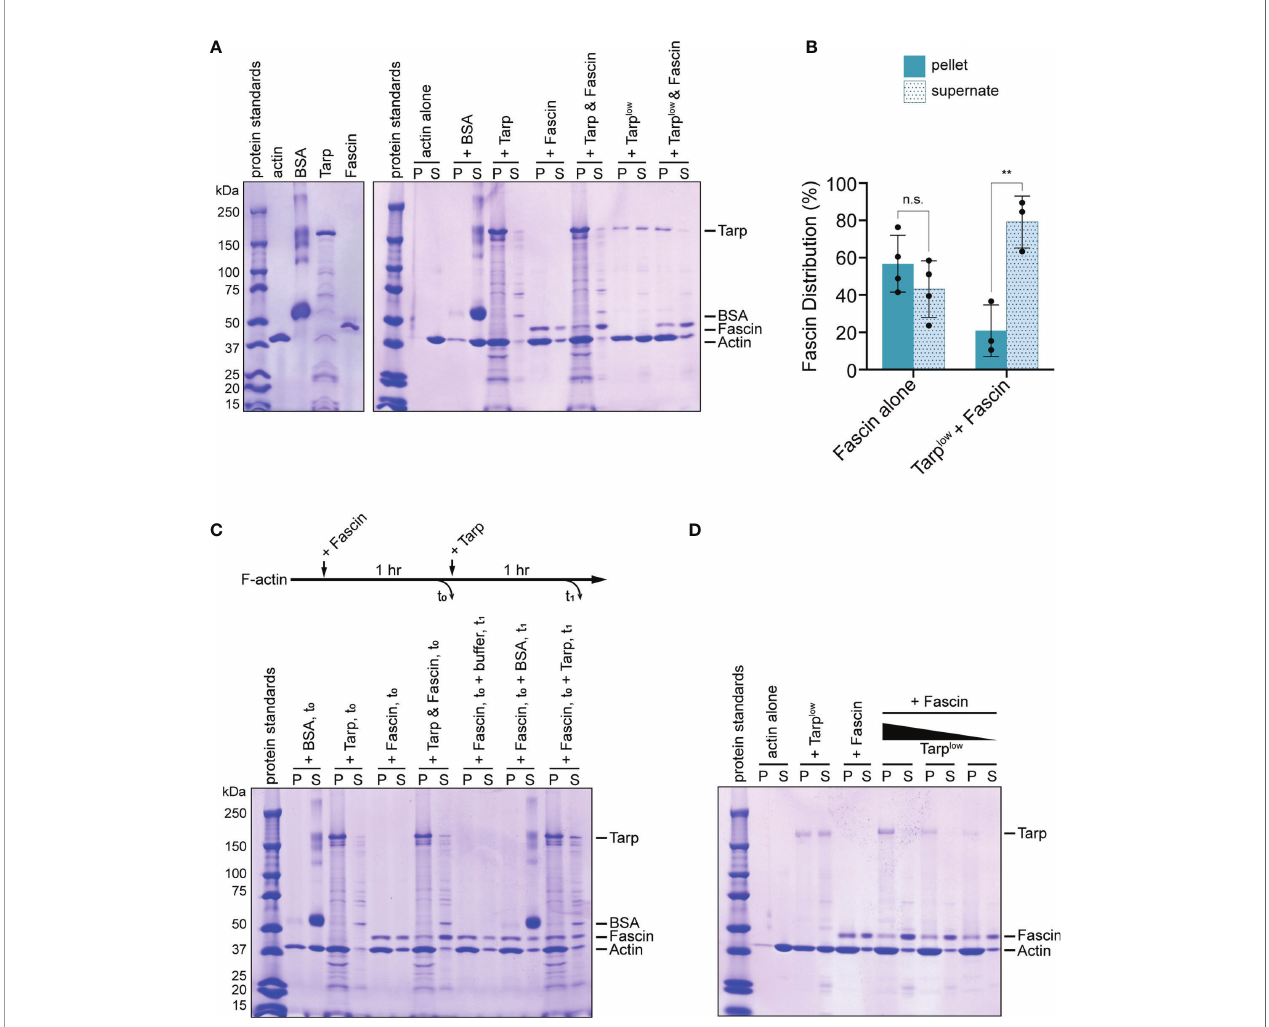
FIGURE 6 | Tarp outcompetes Fascin in F-actin bundling formation in vitro . (A) An in vitro F-actin bundling assay was performed using puri fi ed Tarp and Fascin, alone or in combination. Bovine serum albumin (BSA) does not interact with F-actin and serves as negative control. F-actin bundles, together with associated bundling proteins, are enriched in the pellet fraction. In the presence of Tarp or Fascin, actin is enriched in the pellet fraction as well as the corresponding F-actin bundlers. Simultaneous addition of Tarp and Fascin to F-actin results enrichment of actin and Tarp in the pellet fraction, while the majority of Fascin is found in the supernate. Exclusion of Fascin from the pellet fraction still occurs even with a reduced amount of Tarp (Tarp low ). (B) Fascin distribution following F-actin bundling assays when added alone (Fascin alone) or simultaneously with Tarp (Tarp low + Fascin). Multiple trials are represented. Fascin is predominantly found in the supernate fraction when Tarp is present during F-actin bundling (Welch ’ s t test, **p<0.01). n.s. not signi fi cant. (C) In vitro F-actin bundling was further assessed after sequential addition of Tarp and Fascin. Individual proteins, as well as Tarp and Fascin together, added at the beginning of the assay and sampled at t 0 , recapitulated the original fi nding. Fascin, followed by the addition of buffer or BSA, at t 0 , resulted in F-actin bundling and enrichment of Fascin in the pellet fraction, upon analysis at t 1 . Subsequent addition of Tarp at t 0 to Fascin-assembled bundles resulted in enrichment of Tarp in the pellet fraction when, with minimal impact on Fascin distribution, upon analysis at t 1 . (D) When added simultaneously, Tarp is able to outcompete Fascin during F-actin bundle formation even with diminishing amounts of Tarp. Individually, Tarp (Tarp low ) and Fascin ef fi ciently form F-actin bundles and Fascin is highly enriched in the pellet fraction. On the other hand, Fascin is predominantly shifted to the supernate fraction, across all Tarp concentrations